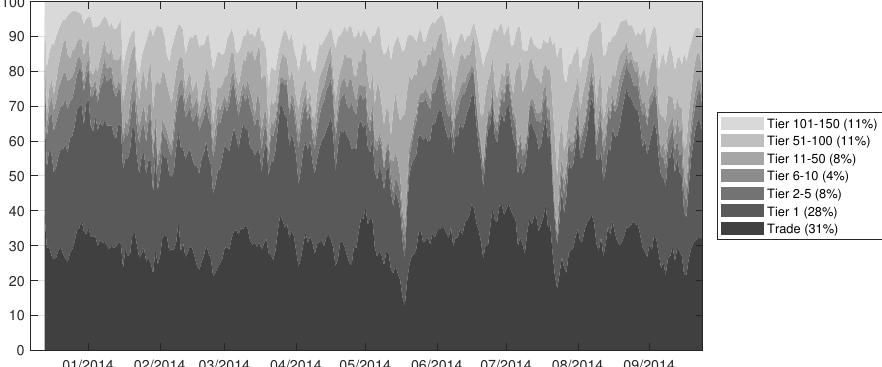
Figure 5. Information shares of trade and limit orders. They are computed daily from a vector error correction model on one-minute data of trade price, and limit order prices at tier 1, tiers 2–5, tiers 6–10, tiers 11–50, tiers 51–100, and tiers 101–150. For each limit order category, the price is the average price of all bid and ask orders in the relevant tiers, weighted by the corresponding depth. Data are from BTC-e for the period from 7 December 2013 to 24 September 2014. Each day is defined to be from 0:00:00 to 23:59:59 ET. The figure shows the 7-day moving averages of daily information share